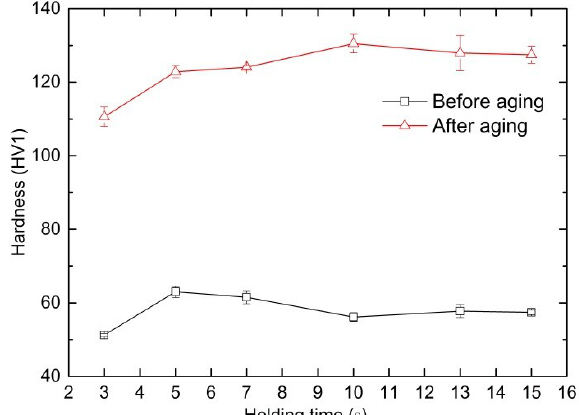
Figure 9. Effects of SHT time on the hardness of 6061 aluminum alloy samples heated by conduc- tion heating.